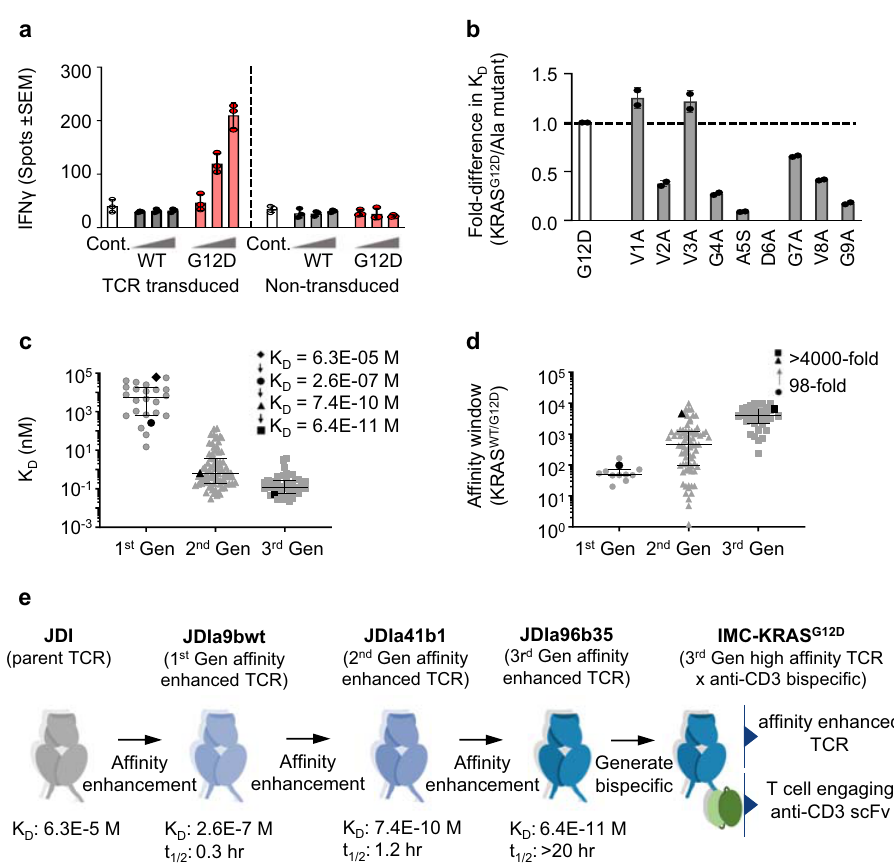
K D : 2.6E-7 M t 1/2 :0.3 hr Fig. 1 | Af fi nity-enhanced version of the JDI TCR retains the ability to distin- af fi nity maturation. Error bars represent median with interquartile range in each guish KRAS G12D from KRAS WT . a T cells transduced with the JDI TCR were co- generation(Gen;1stGen n =24,2ndGen n =78,3rdGen n =41).Datashowninblack symbolsareforselectedmutantsshowninFig.1eandcalculatedfromatleast n =2 cultured with SUP-B15 cells (HLA-A*03:01+/HLA-A*11+) incubated with 0.1, 1 or experiments. d Difference in binding af fi nity of TCR mutants towards KRAS WT and 10 µ MKRAS WT (WT)orKRAS G12D (G12D)peptide.Tcellactivationwasassessedusing IFN ɣ capture ELISPOT assay. Unpulsed antigen presenting cells (Cont.) and KRAS G12D plotted as af fi nity window ( K D KRAS WT / K D KRAS G12D pHLA). Error bars represent median with interquartile range in each generation (1st Gen n =11, 2nd untransducedTcellswereusedascontrols.Meandataofthreebiologicalreplicates Gen n =78,3rdGen n =35).Datashowninblacksymbolsarecalculatedfromatleast ± SEM from one experiment is shown b binding of the JDI TCR to alanine sub- n =2 experiments . e Schematic representation of the evolution of parent JDI TCR stituted KRAS G12D peptides. Mean K D values ( n =2) plotted as fold-change in K D compared to KRAS G12D (G12D). Ratio is calculated as K D of JDI TCR binding to intoahighaf fi nityTCRxCD3-bispeci fi cIMC-KRAS G12D .Sourcedataareprovidedasa KRAS G12D /Alanine mutant. c Af fi nity ( K D ) of mutants from three generations of Source Data fi